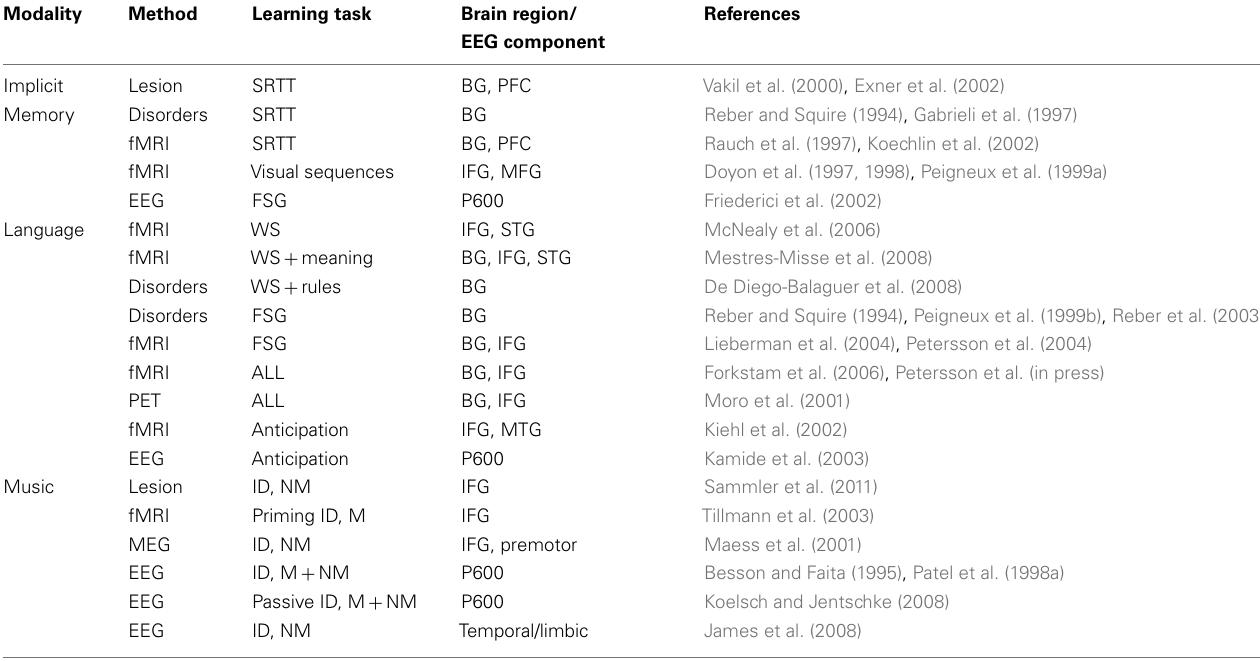
Table 1 | Summary of representative neurological findings associating implicit memory, language, and